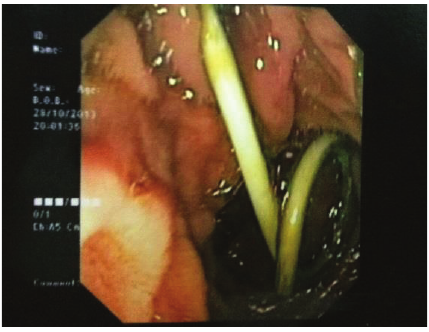
Figure 2: Postoperative ERCP showing a coiled drain in the duodenum.